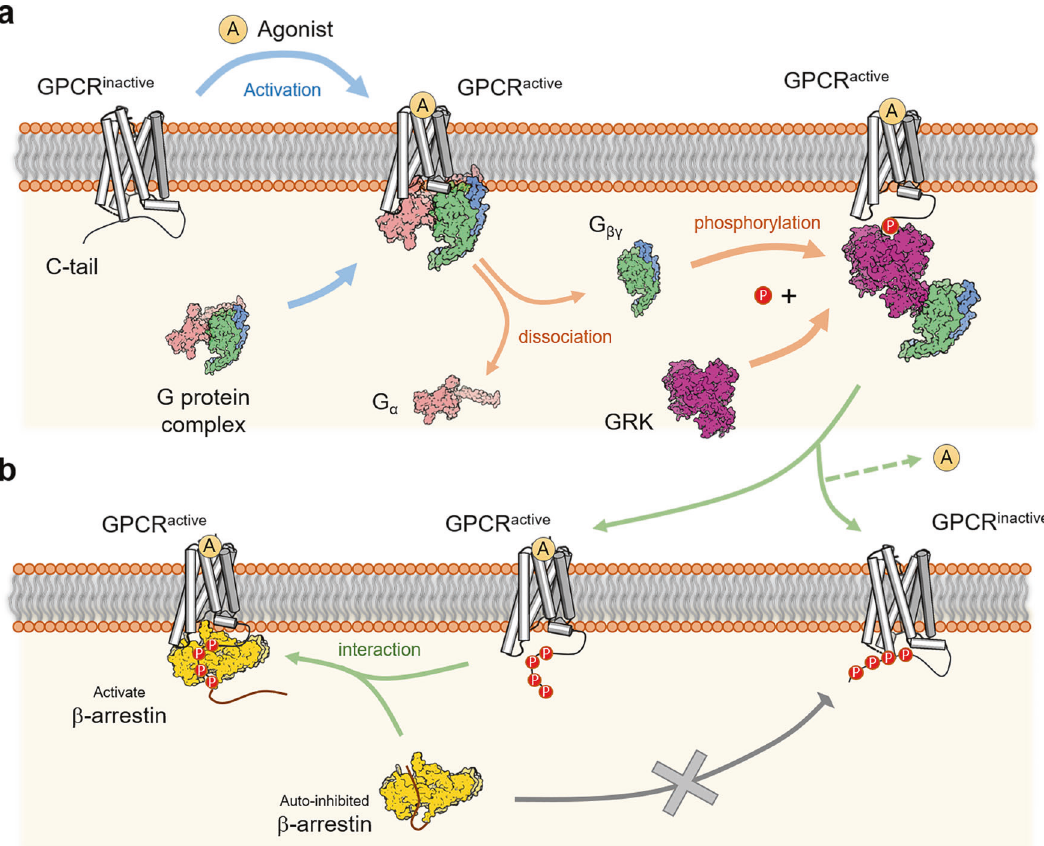
Fig. 1 Schematic illustration of the activating procedure of GPCR as well as the agonist-induced signaling event. a (Up) The heterotrimeric G protein complex interacts with the activated GPCRs, therefore triggers the dissociation of the G α and G βγ subunit, where the latter recruits GRKs to phosphorylate the C-terminal tail of GPCR. b (Down) The β arr tends to interact with activated and phosphorylated GPCRs than the phosphorylation-only